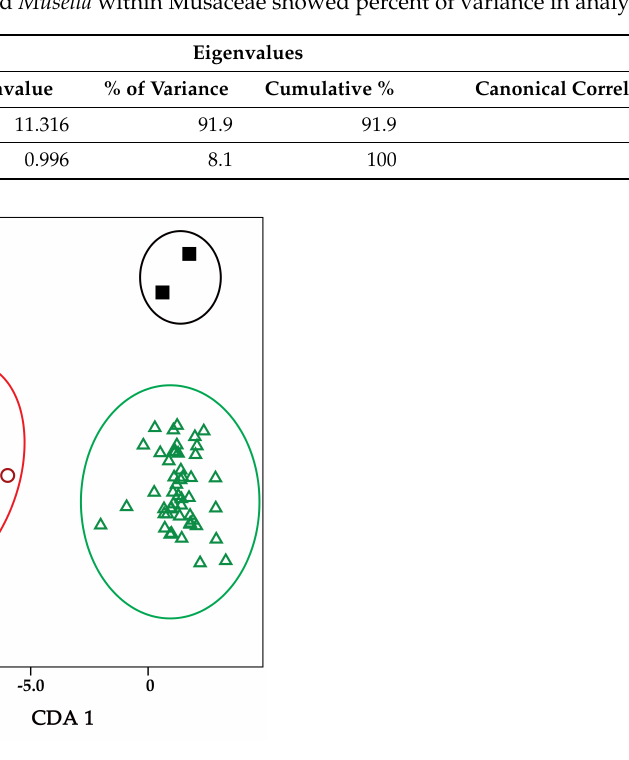
Figure 2. Scatter plot of the first two discriminant axis based on 15 male flower traits from 59 OTUs shows grouping of Musa , Ensete and Musella within the Musaceae. Table 4. Pooled within-groups correlations between discriminating variables and standardized canonical discriminant functions of Musaceae. Variables ordered by absolute size of correlation within function. The correlations of floral characters which most significantly distinguished Ensete from Musa and Musella are indicated in bold typeface in Function 1, meanwhile, those that separated Musella from Ensete and Musa are in bold typeface in Function